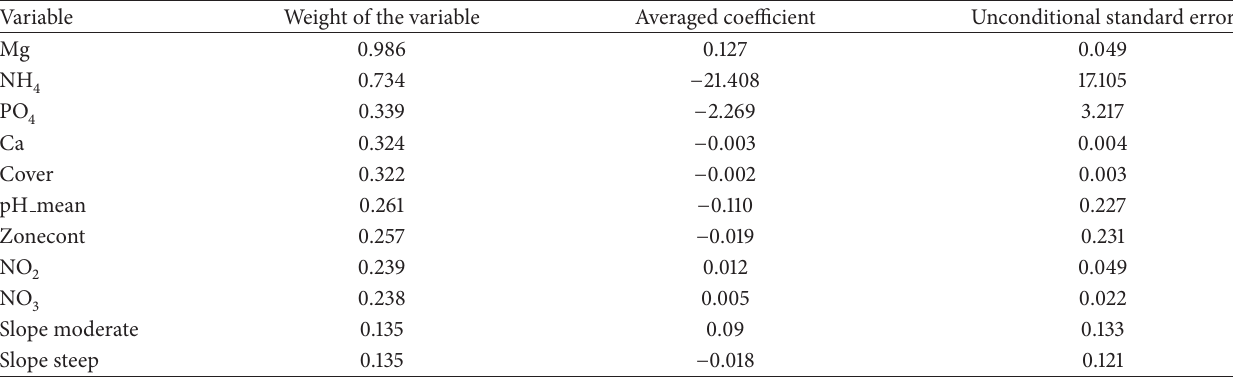
Table6:ResultsoftheAICstepwisemodelselectionforprobabilityofpresenceof Cratoneuron filicinum showingthebestsignificantvariables selected based on their weight using the complete dataset.